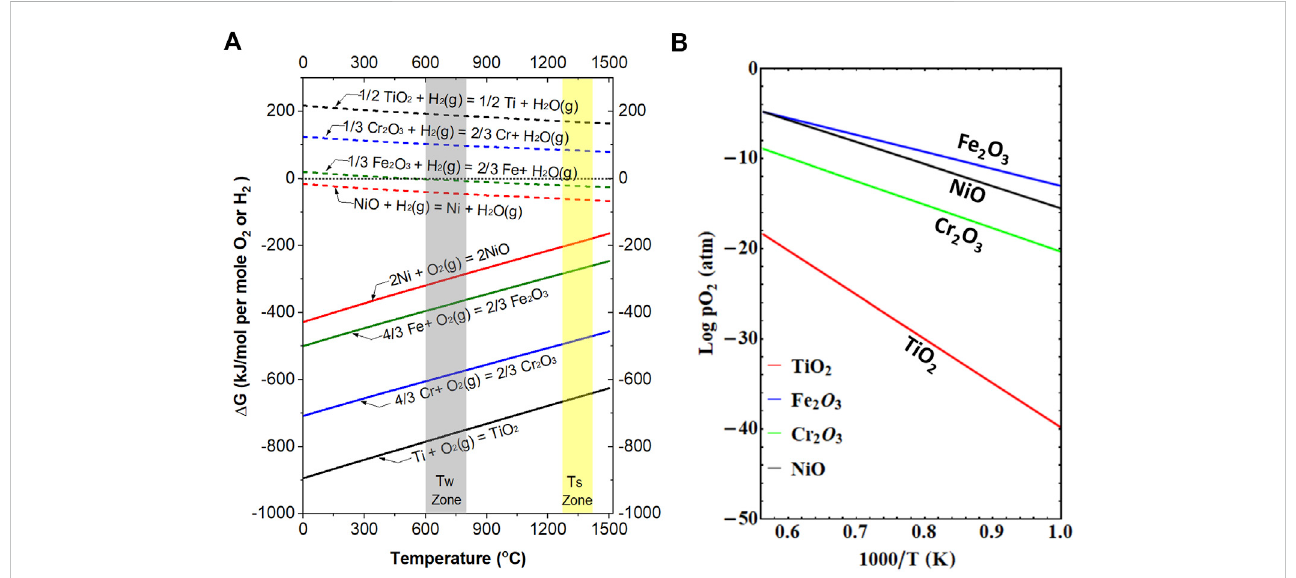
FIGURE 5 (A) Thermodynamics of the oxidation of Fe, Cr, Ni, and Ti metals and the reduction of their corresponding common oxides Fe 2 O 3 , Cr 2 O 3 , NiO, and TiO 2 , respectively. (B) Dissociation oxygen pressure for Fe 2 O 3 , Cr 2 O 3 , NiO, and TiO 2